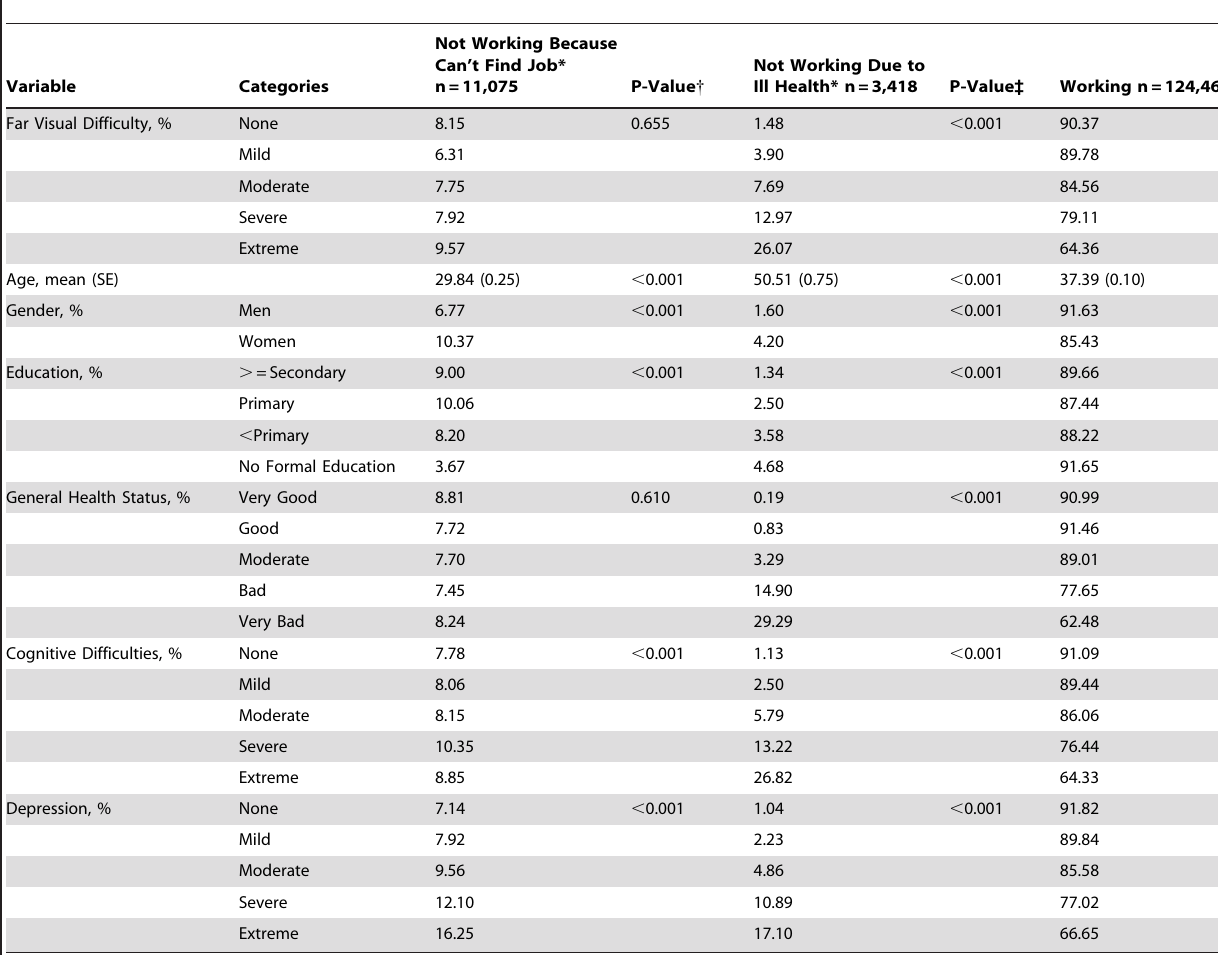
Table 2. Employment status of WHS participants by selected characteristics.